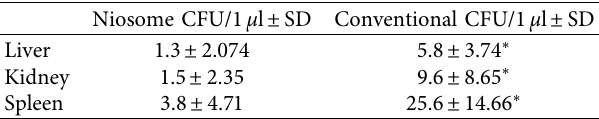
Table 1: Bacterial counts in liver, spleen, and kidneys (1 μ l) on day 10, after treatment with levofloxacin (niosome) and levofloxacin (conventional) in rats inoculated with Pseudomonas aeruginosa